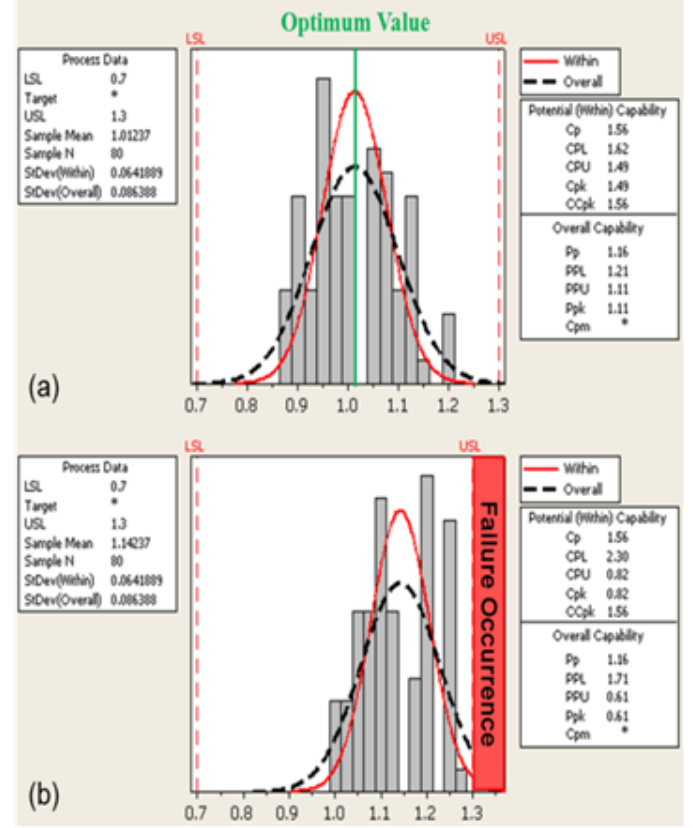
Figure 17. Process capability of trace top/bottom ratio (a) robust design with CPM and (b) uncontrolled system design with occurrence of failure